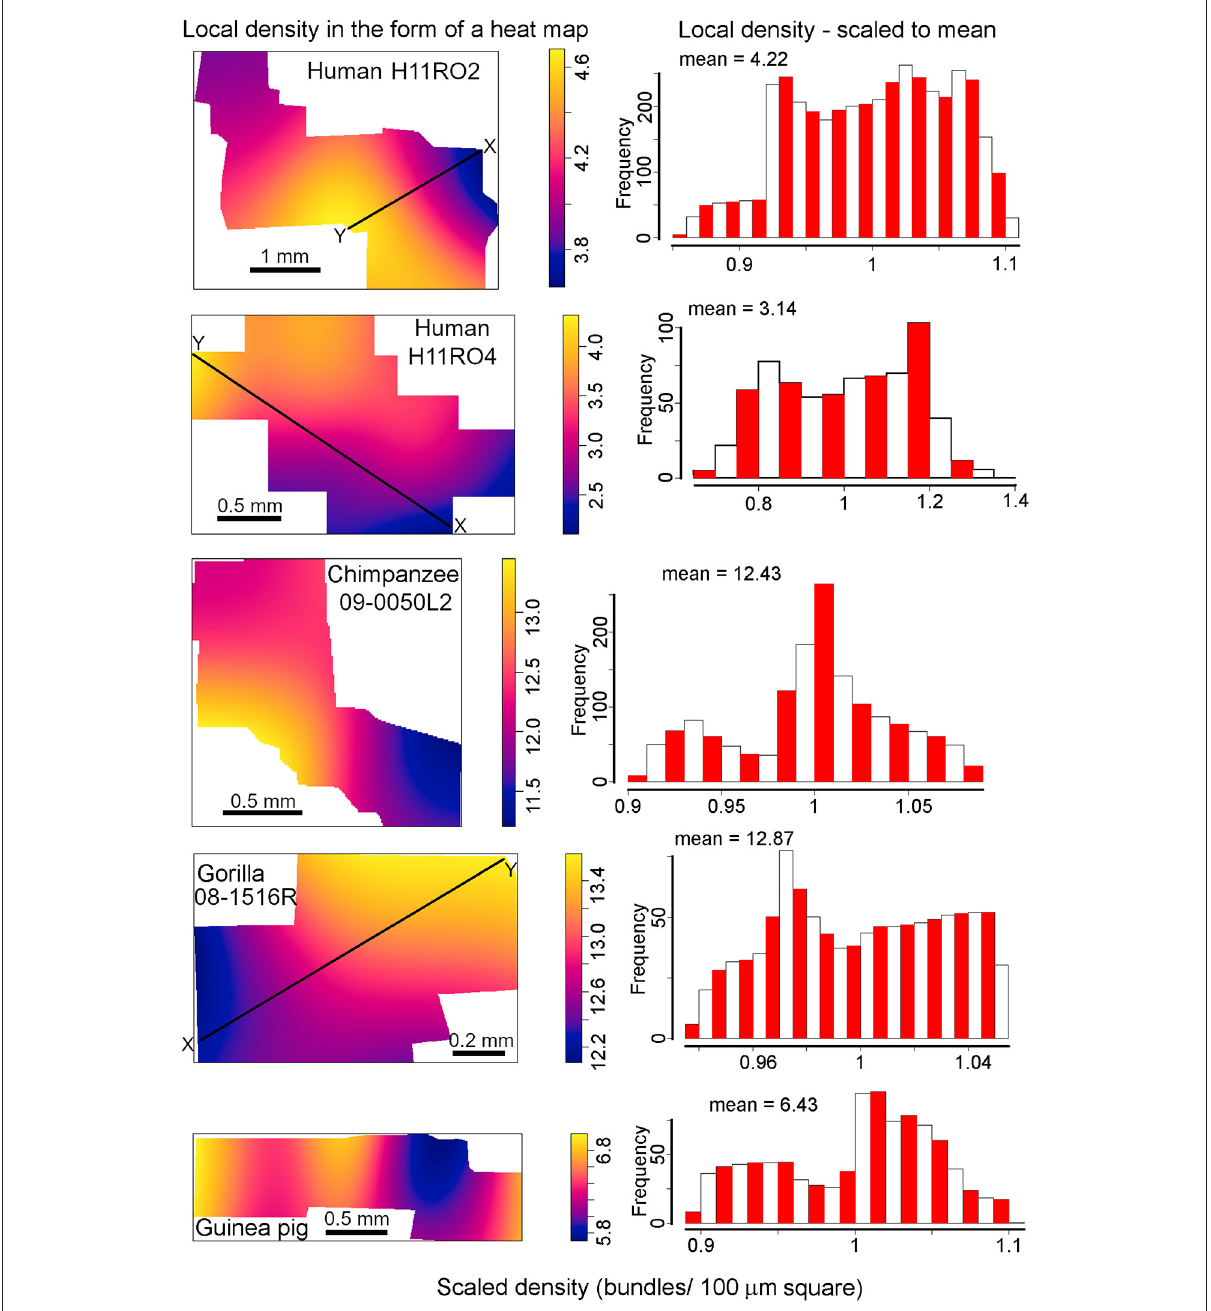
FIGURE9 Digital reconstructions of myelinated bundles in tangential sections through layers IVC or VA from the four species with the most regular bundles. The density of the bundles is displayed as a heat map. Beside each heat map is a histogram showing the distribution of density values for bundles in the section relative to the mean density which was normalized to represent 1. The mean value above each histogram gives the density in terms of bundles within a square with a side of 100 µ m. These values have to be multiplied by 100 to give the density in mm − 2 . The black lines labeled “X to Y” indicate monotonic variations in density which are given numerical values in the text.